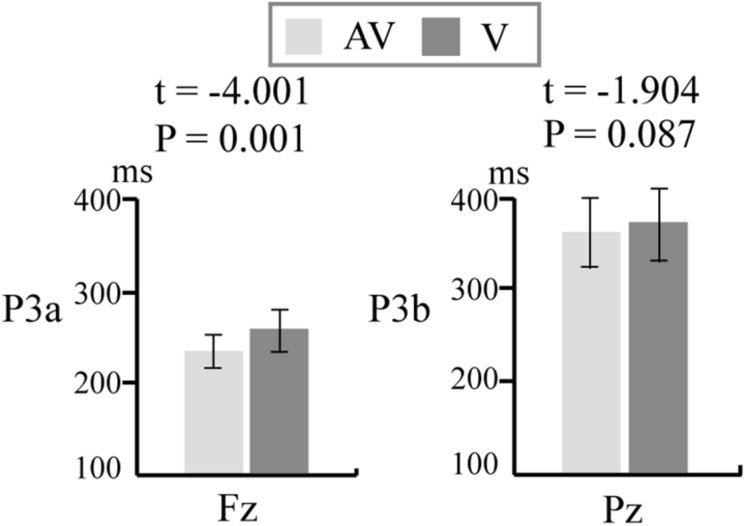
Comparison of latency (means ± SEM) of P3a at Fz and P3b at Pz between the V and AV spelling paradigms. V, visual spelling paradigm; AV, audiovisual spelling paradigm.